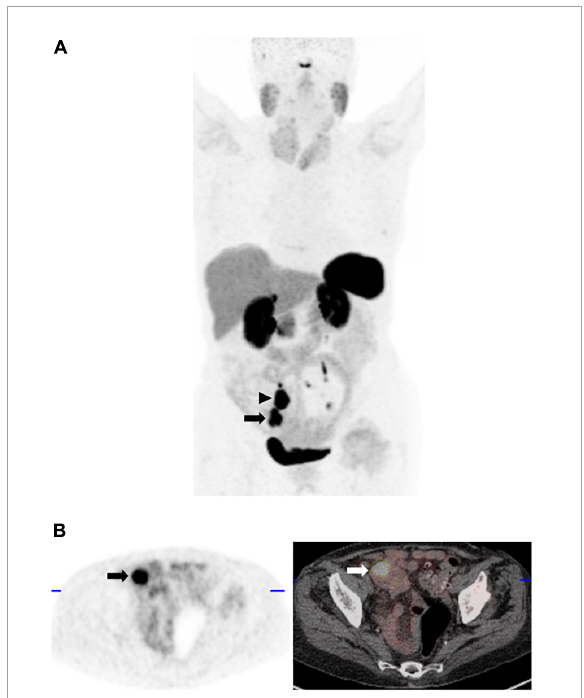
FIGURE9 42-year-old man with clinical suspicion of small bowel NET. (A) Maximum intensity projection 68 Ga-DOTATATE PET image shows 2 foci of intense abnormal 68 Ga-DOTATATE uptake, greater than splenic uptake (Krenning score 4); the inferior corresponding to a mass in the terminal ileum (arrow), as well as a 68 Ga-DOTATATE-avid mesenteric nodal mass (arrowhead) in keeping with an SSTR-2 overexpressing primary neuroendocrine tumor. (B) Corresponding axial PET (left) and fused PET/CT image at the level of the primary tumor